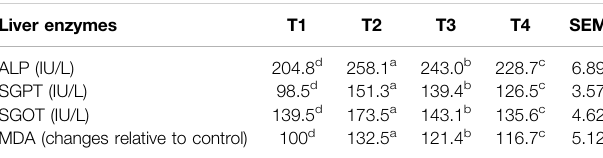
TABLE 5 | The results of liver enzymes and lipid peroxidation.